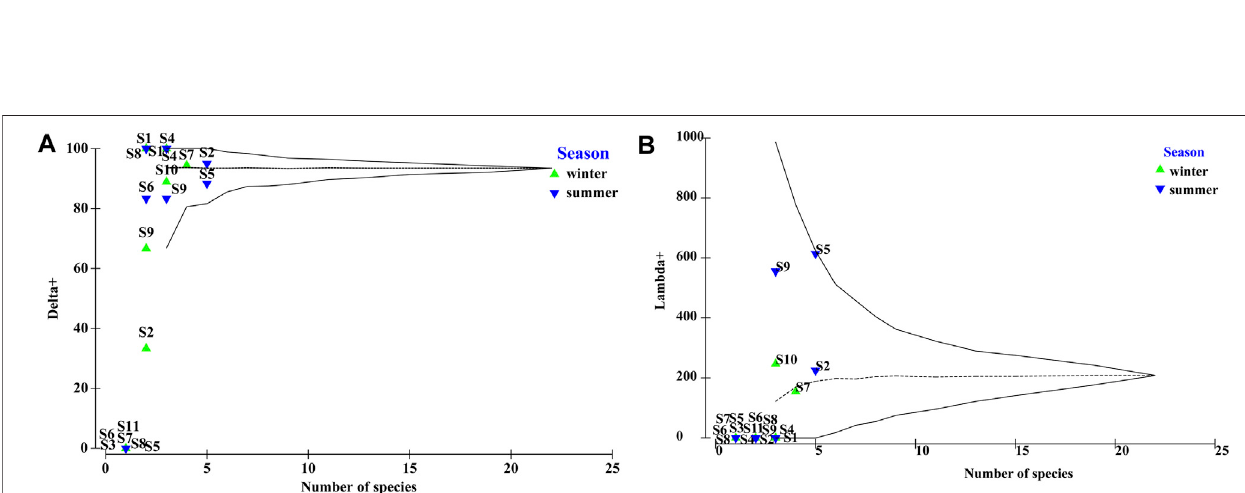
Frontiers in Environmental Science |